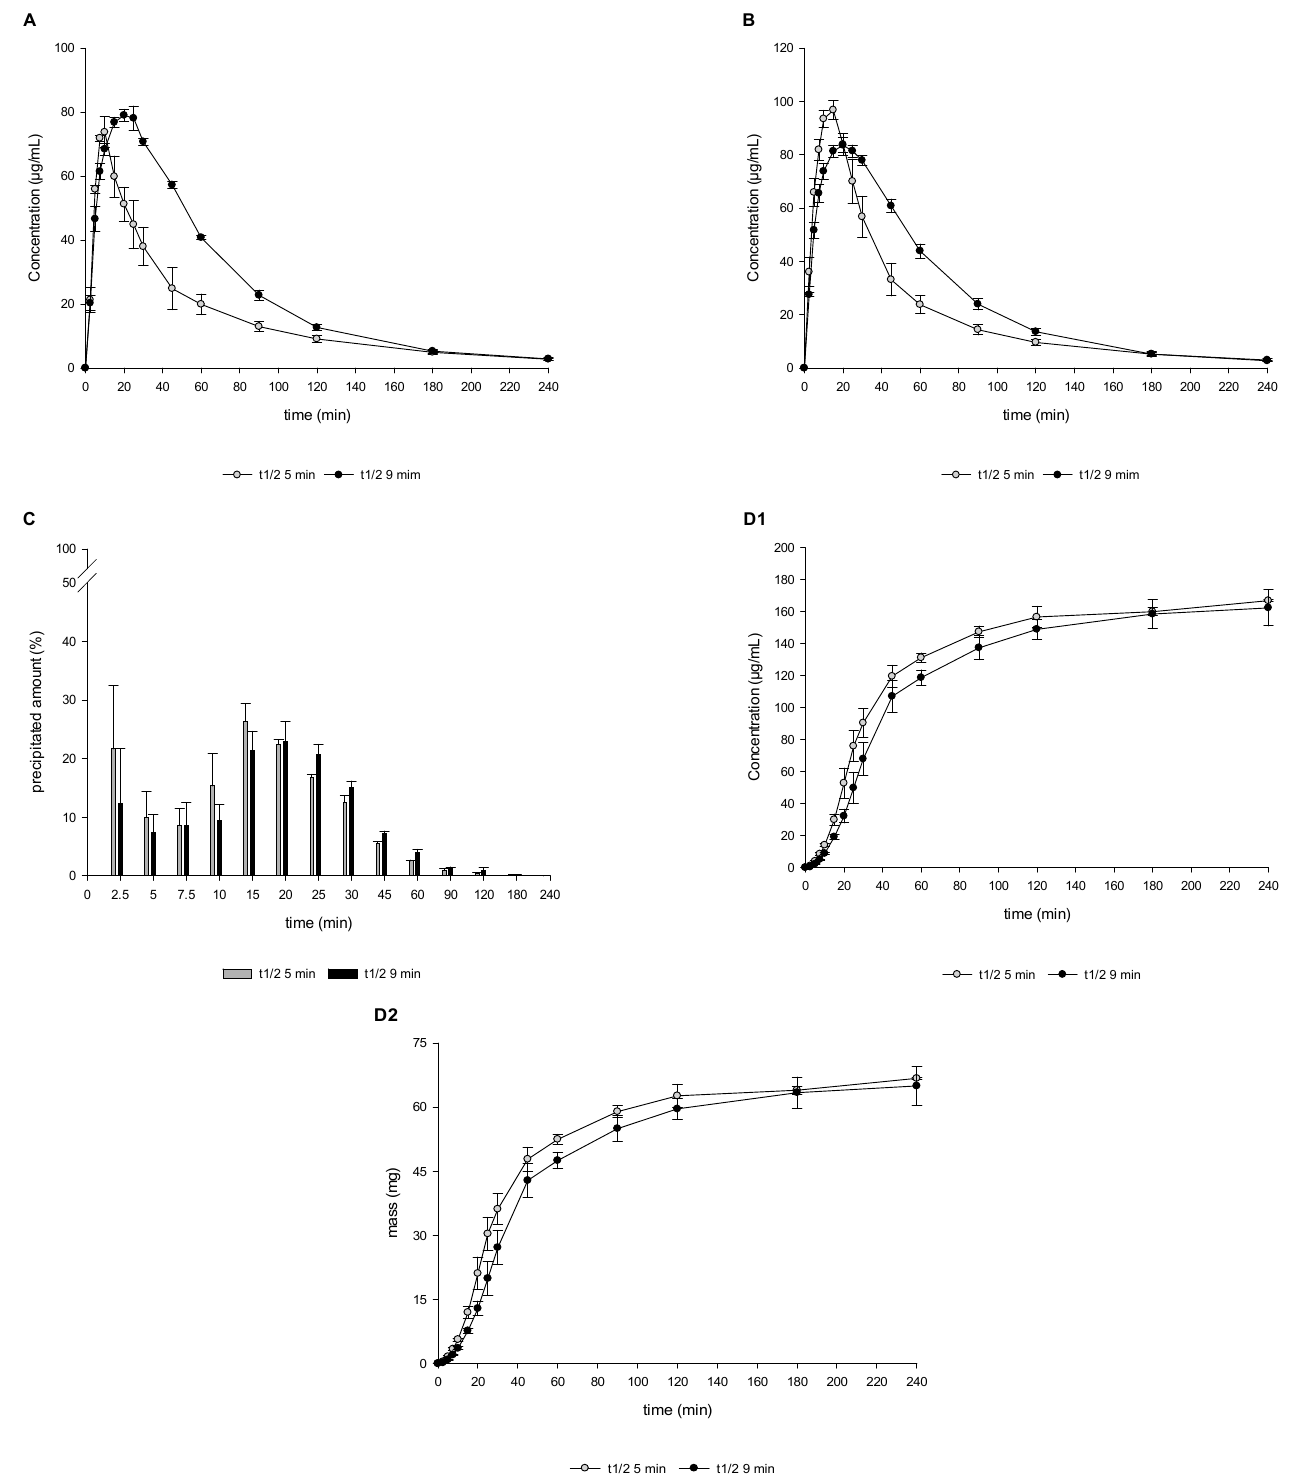
Figure 4. Drug concentration profiles (dissolved, ( A )), total amount profiles (dissolved and undis- solved/precipitate, ( B )), and undissolved/precipitated amount ( C ) obtained from the aqueous filtered and un-filtered phase; partitioning profiles (( D1 ) concentration/time vs. ( D2 ) mass/time) obtained from the organic phase during in vitro DTPS experiments using VR of 0.8 at simulated gastric emptying rates of 5 min half-time vs. 9 min half-time and 75 mg IR tablet formulation. The precipi- tated mass/amount (Equations (1) and (4)) must be considered as solid mass/amount consisting of undissolved and precipitated API. Means ± SD, n =3.